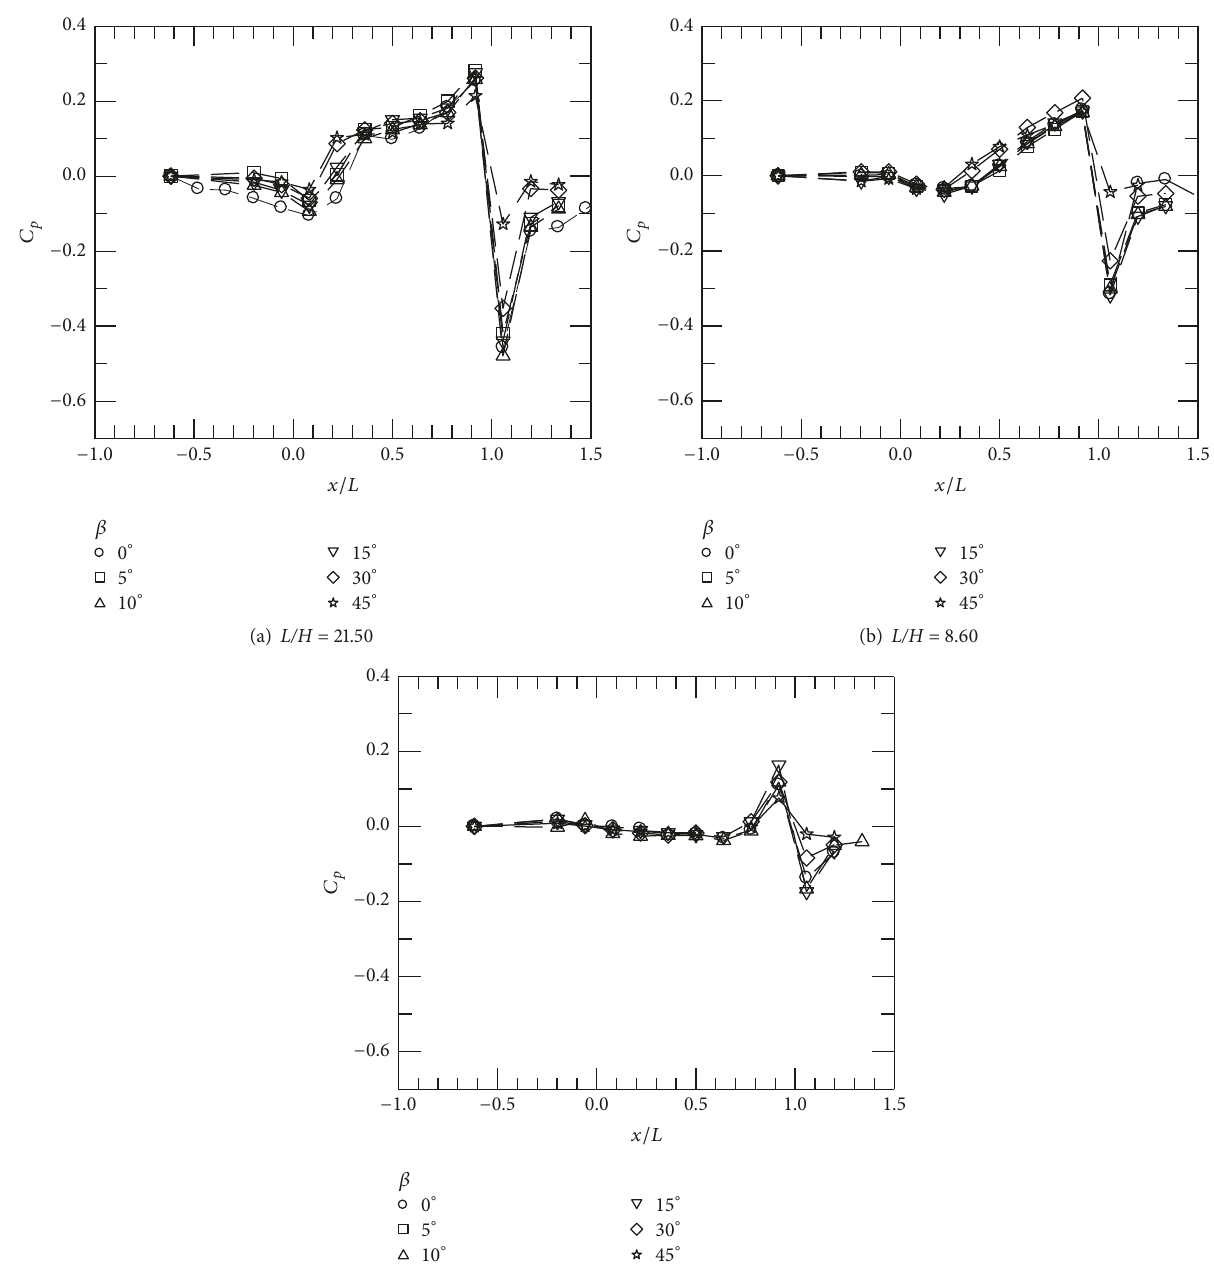
Figure 3: Chord-wise distributions of the surface mean pressure for M = 0.83: (a) L/H = 21.50, (b) L/H = 8.60, and (c) L/H = 4.43.